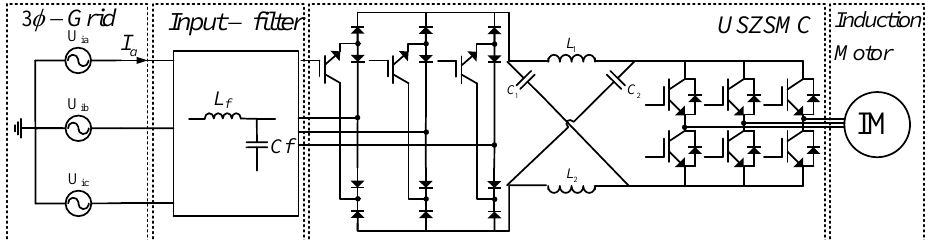
Figure 1. The ultra-sparse Z-source matrix converter topology.